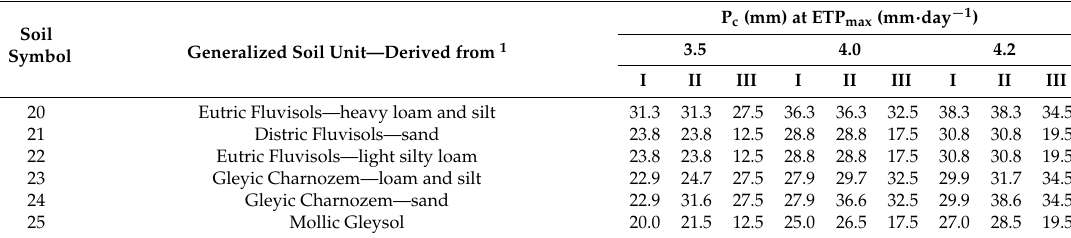
Soil Symbol Generalized Soil Unit—Derived from 1